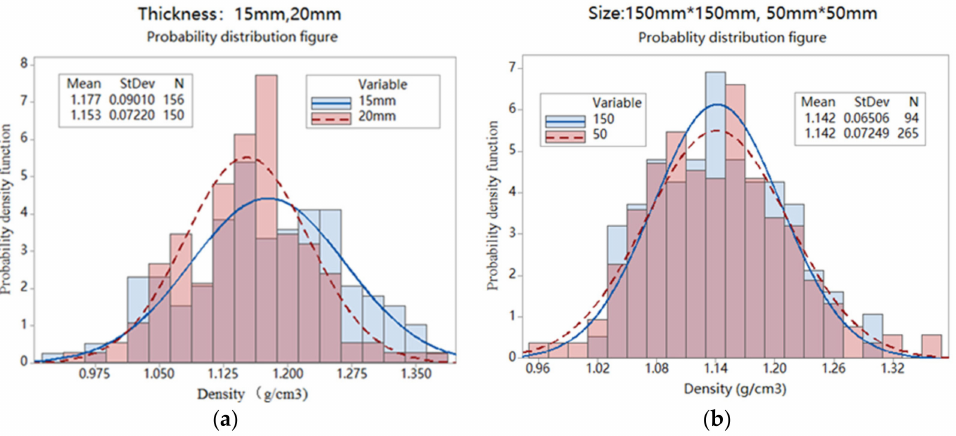
Figure 5. Density histograms for panels with ( a ) different panel thickness and ( b ) evaluation specimen